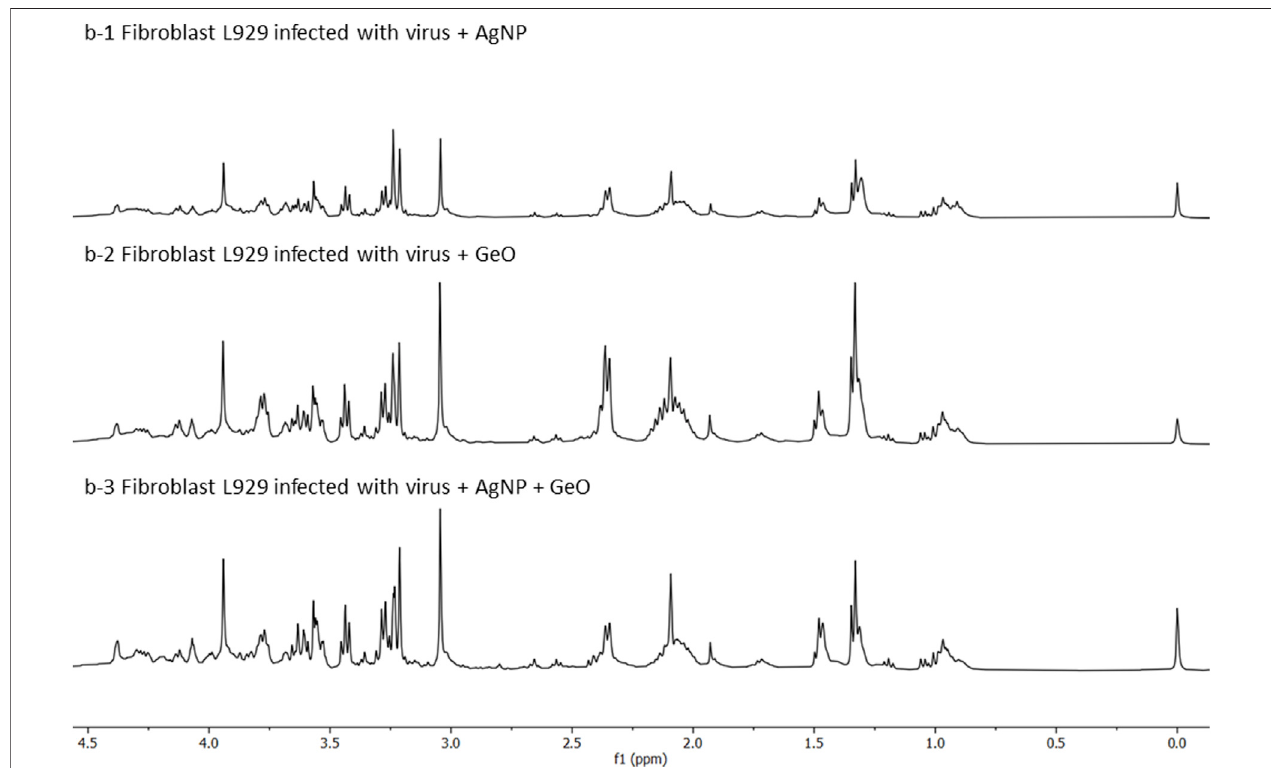
FIGURE 4 | HR-MAS 1 H-NMR spectra in 0.0 – 4.5 ppm region. Charts depict, from top to bottom: (b-1) infected fi broblast L929 cells with the virus MHV-3 in the presence of AgNP@HST (dilution 1:10, v v − 1 ), (b-2) infected fi broblast L929 cells with the virus MHV-3 in the presence of GO (dilution 1:10, v v − 1 ), and (b-3) infected fi broblast L929 cells with the virus MHV-3 in the presence of GO@AgNP@HST (dilution 1:10, v v − 1